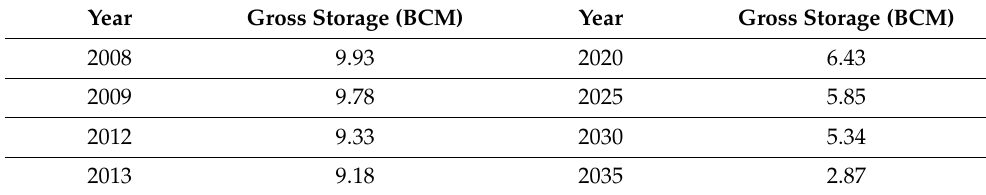
Table 8. Tarbela Reservoir Past and Future Storage